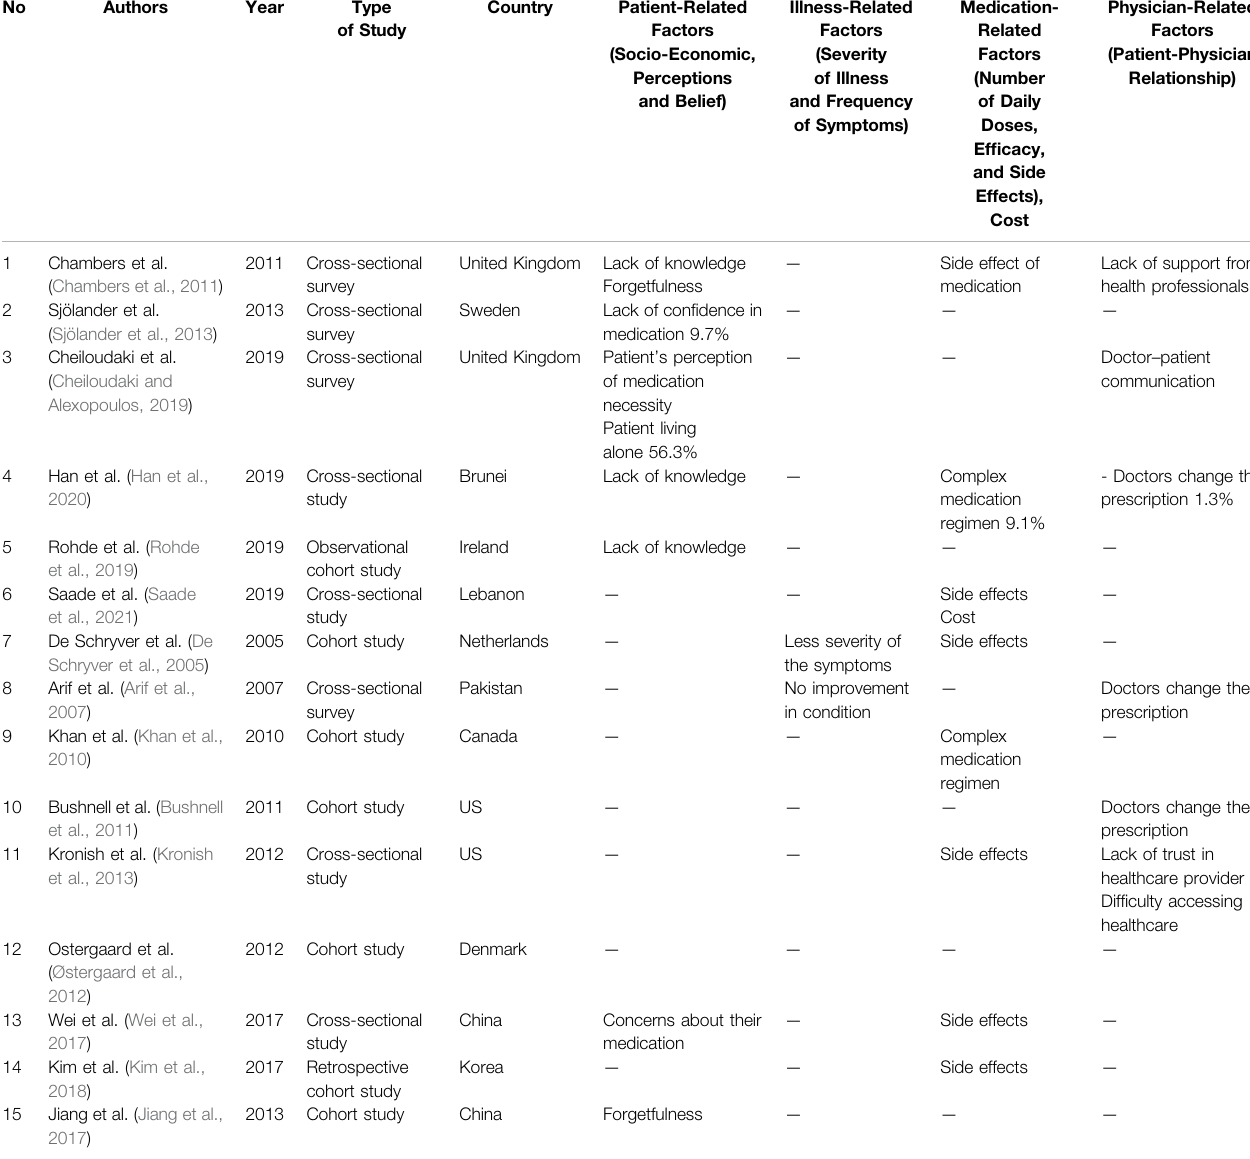
TABLE 4 | Factors associated with medication